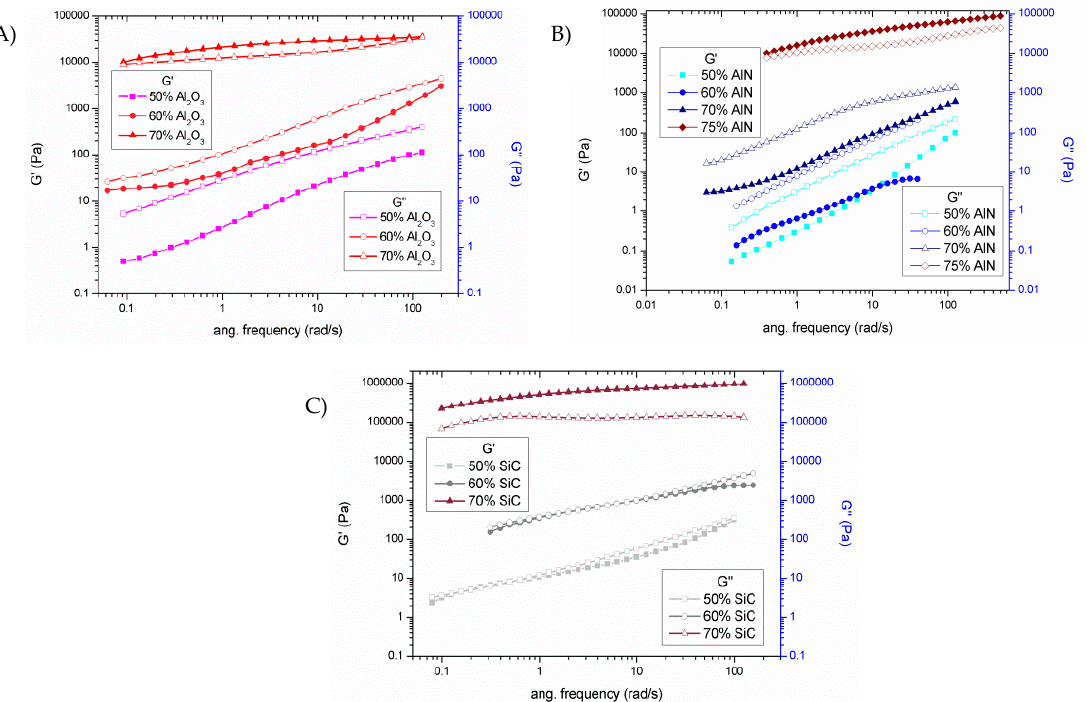
Figure 3. Plots of G’ and G’’ versus frequency in frequency sweep tests at 30 °C for the different formulations studied with different fillers: ( A ) Al 2 O 3 ; ( B ) AlN; ( C ) SiC.